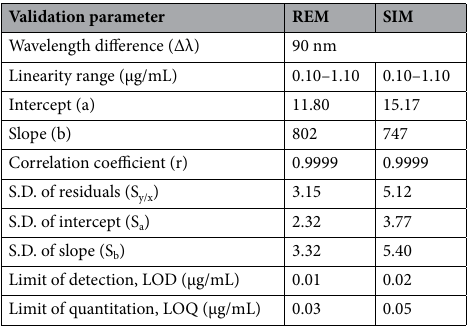
Table 1. Analytical performance data for the proposed